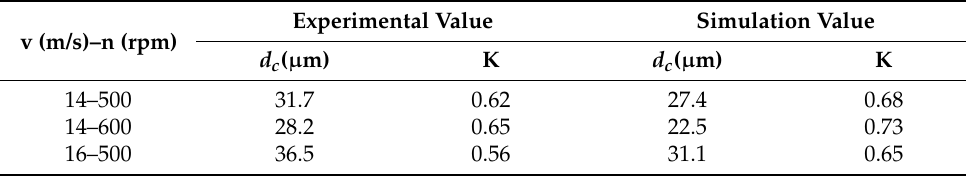
Table 5. Comparison of d c and K between the experiment and